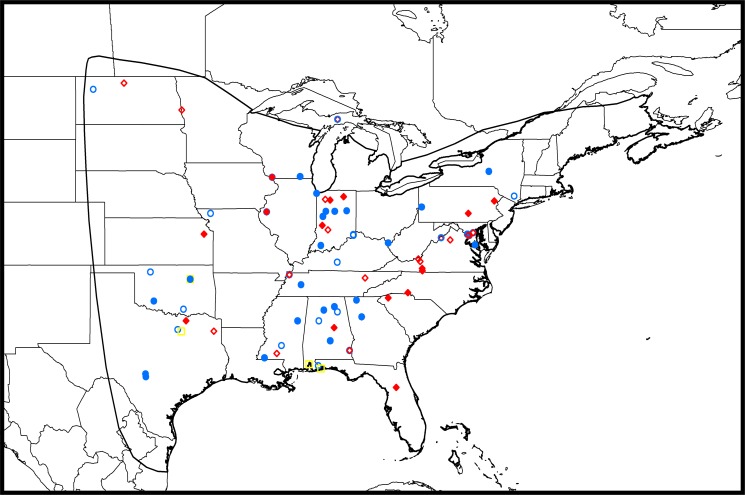
Map of collection sites of museum specimens within the known range of L. borealis.Red diamonds, male; blue circles, female; yellow squares, sex unknown. Solid symbols represent samples of males and females collected between June 14 and August 7 and open symbols represent samples of males and females collected outside of this period, as well as the four bats of unknown sex. Some symbols represent the location at which multiple bats were collected. The dark line represents the approximate geographic range throughout which the red bat occurs (IUCN, 2008).